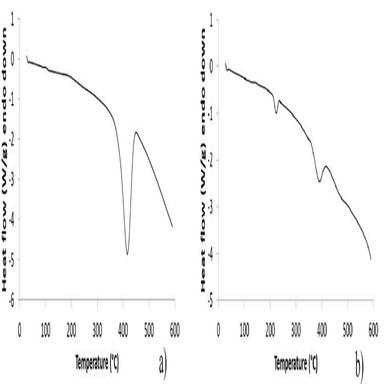
DSC curves of W3 (a) and W9 (b) in the range 25÷600 ◦C.